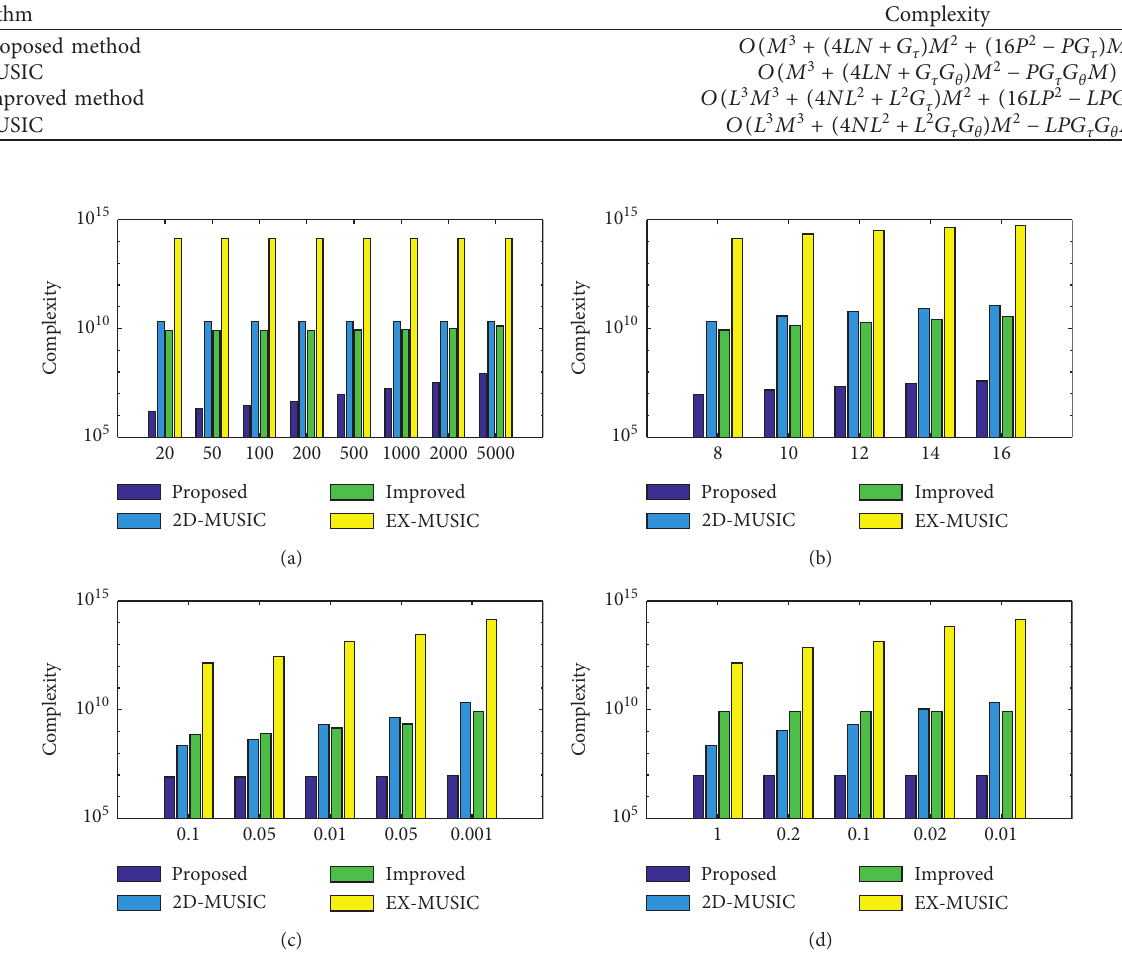
Figure 2: Complexity comparison: (a) change with time intervals when M � 8 , Δ τ � 0 . 001 ns , Δ θ � 0 . 01 ° ; (b) change with sensor number when N � 500 , Δ τ � 0 . 001 ns , Δ θ � 0 . 01 ∘ ; (c) change with Δ τ when N � 500 , M � 8 , Δ θ � 0 . 01 ∘ ; and (d) change with Δ θ when N � 500 , M � 8 , Δ τ � 0 . 001 ns. Table 2: Information about relevant